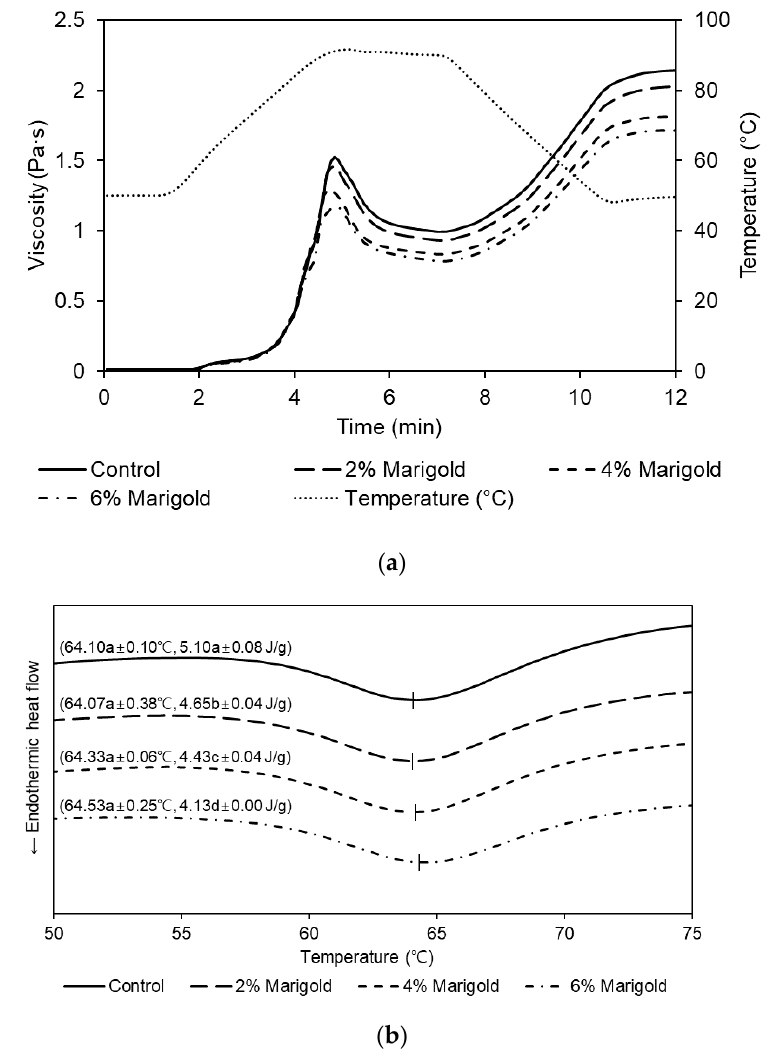
Figure 1. Effect of marigold powder on the pasting ( a ) and thermal ( b ) properties of wheat flour (means with different letters in the same column differ significantly at p < 0.05).